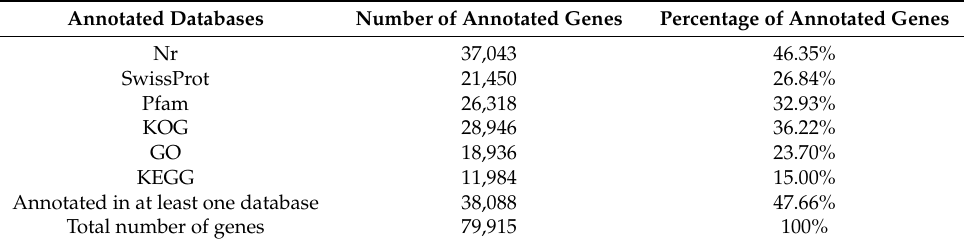
Table 1. Annotations of the yellow horn transcriptome.